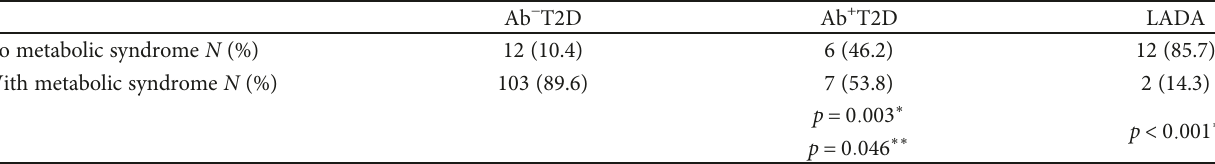
Table 4: Prevalence of metabolic syndrome in T2D and